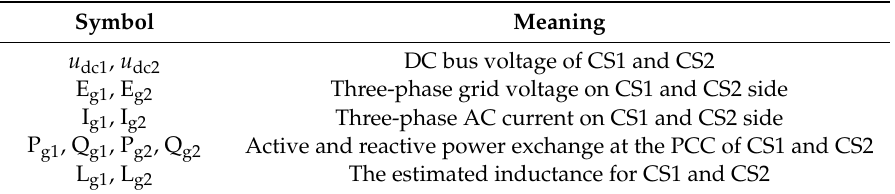
Table 2. Symbols used in the simulation results and their meanings.